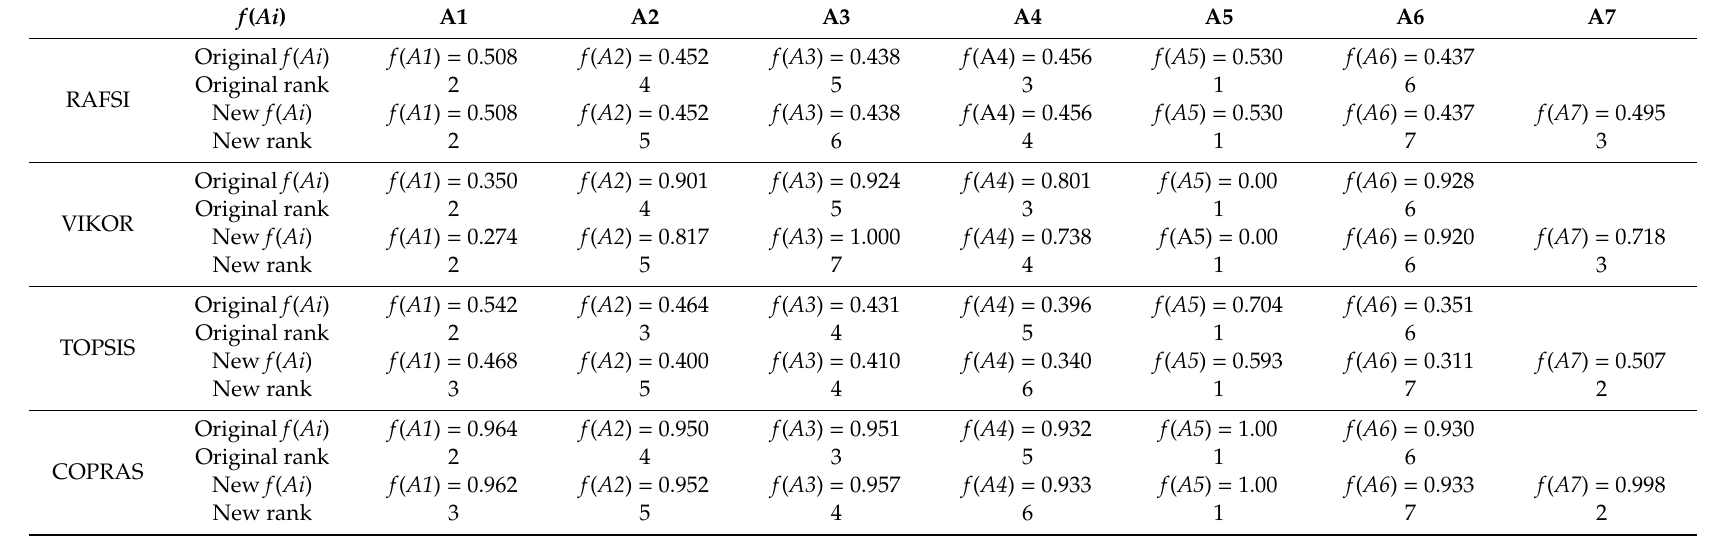
Table 3. Ranking pre-orders for the old and new set of the